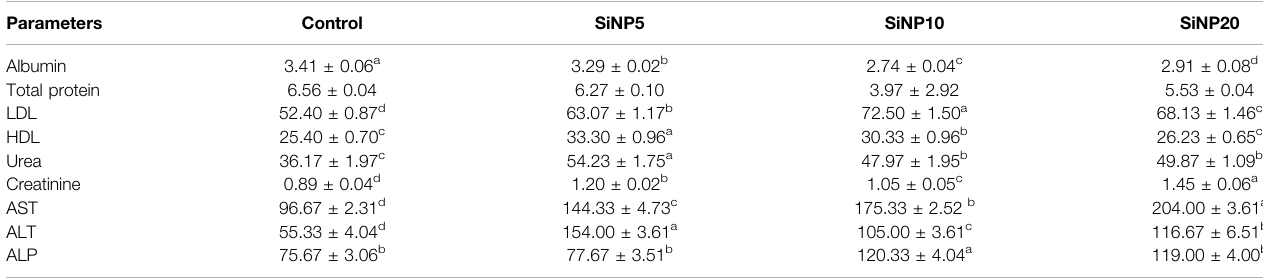
TABLE 5 | Serum biochemical parameters of rats after 24-h gavage with different levels of silica nanoparticles including zero (as the control), 5 (SiNP5), 10 (SiNP10), and 20 (SiNP20). Parameters